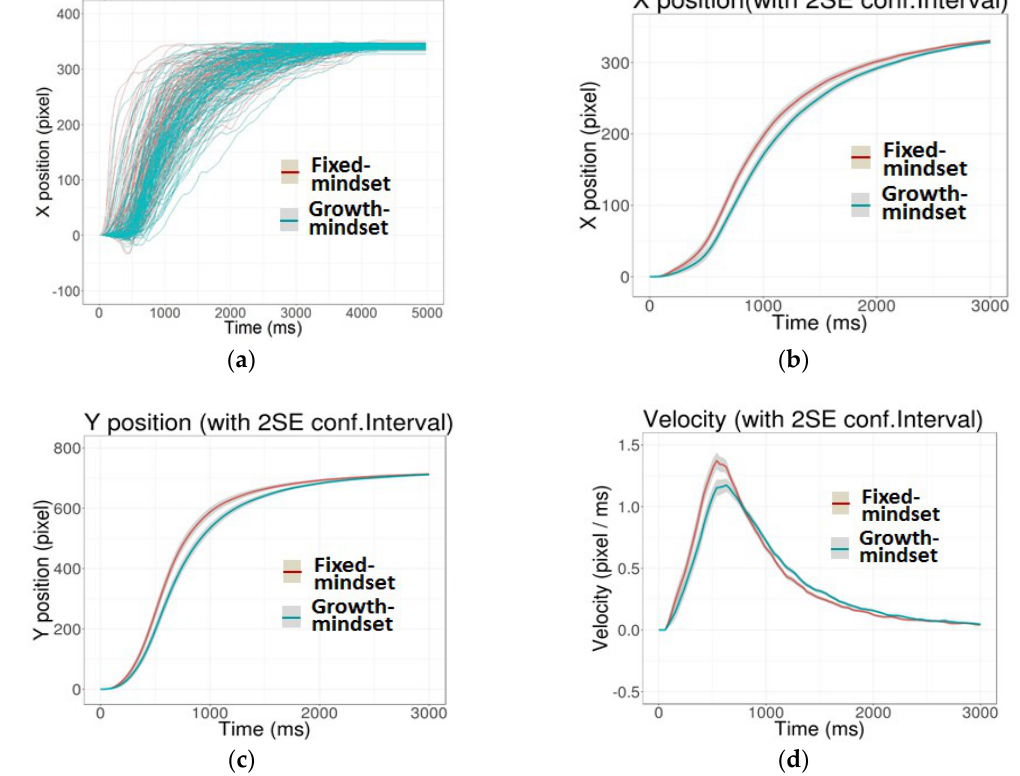
Figure 4. ( a ) Average x-coordinate positions that were collapsed over 150 trials were calculated for individual participants, and ( b – d ) mean trajectories obtained in the two mindset conditions were shown separately together with 2 standard error confidence intervals (shaded areas). X–Y coordinate positions ( b , c ), and velocity ( d ) of the two mindset conditions were contrasted by red (fixed-mindset) and green (growth-mindset) lines. Shaded areas represent confidence intervals measured by two standard error (SE) units.